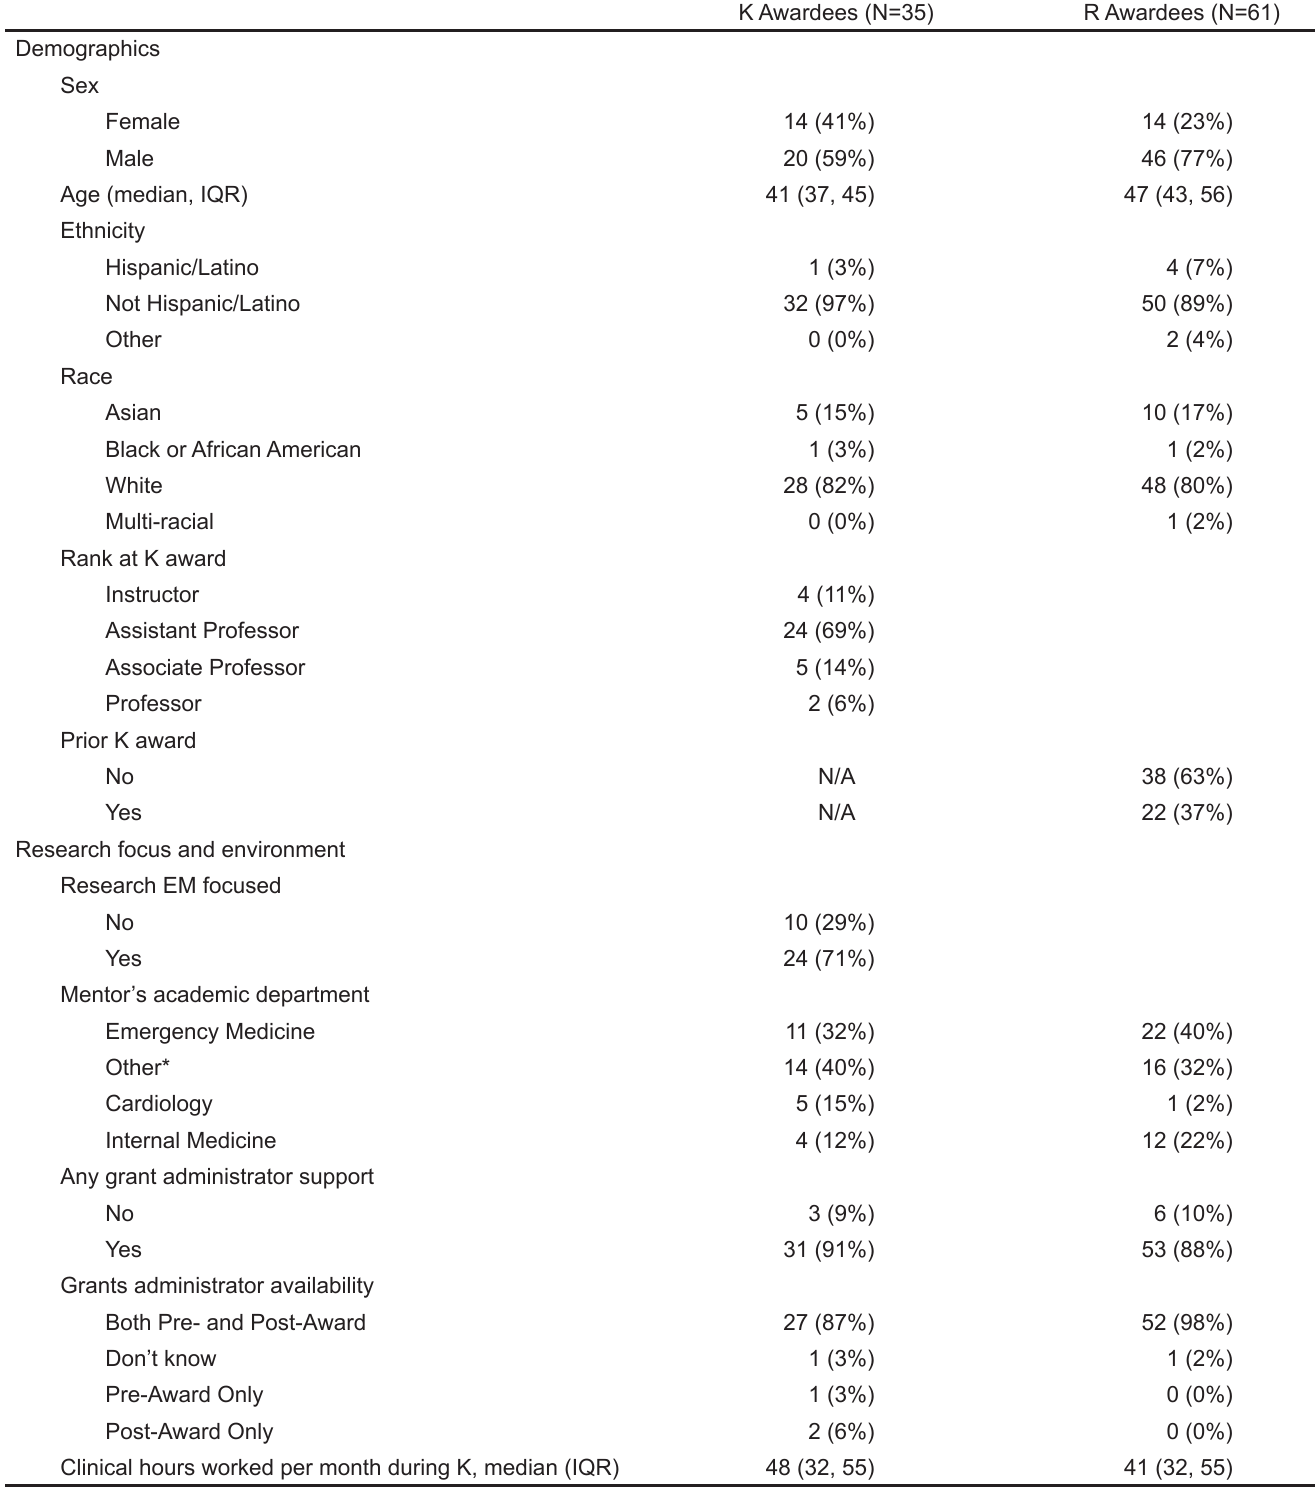
Table 2. Principle investigator survey